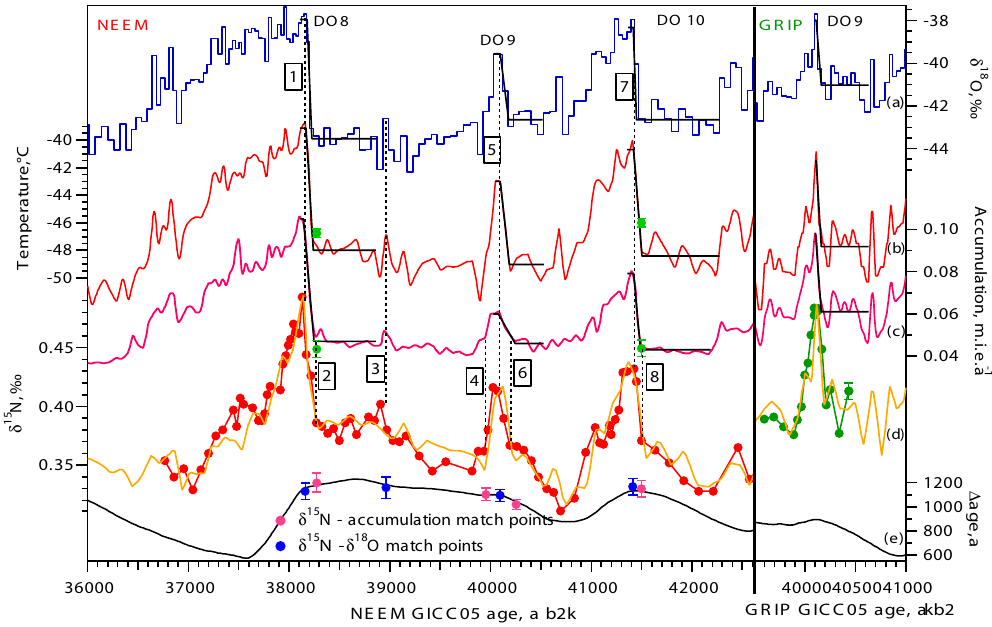
Fig. A3. δ 15 N reconstruction for NEEM (left) and GRIP (right). (a) δ 18 O profile used to reconstruct the surface temperature profile. (b) Sur- face temperature scenario used in the Goujon model (red line) and in the Herron Langway model (NEEM, 2 green dots). (c) Accumulation scenario for the Goujon model (pink line) and the HL model (NEEM, 2 green dots). (d) δ 15 N data measured at LSCE, this study (red (NEEM) and green (GRIP) line and markers) and modeled δ 15 N by the Goujon model (orange line), using temperature and accumulation scenario shown in (b) and (c) , plotted on the ice age scale using the 1 age produced by the Goujon model (e, black line). 1 age tie points are numbered as in Table 2. (e) Markers: tie points between δ 15 N and δ 18 O (blue markers) or accumulation (pink markers), used to constrain the firnification models. Black line: 1 age modeled by the Goujon model. Subplots (a) , (b) and (c) , in black: GS and GI mean states calculated by the rampfit